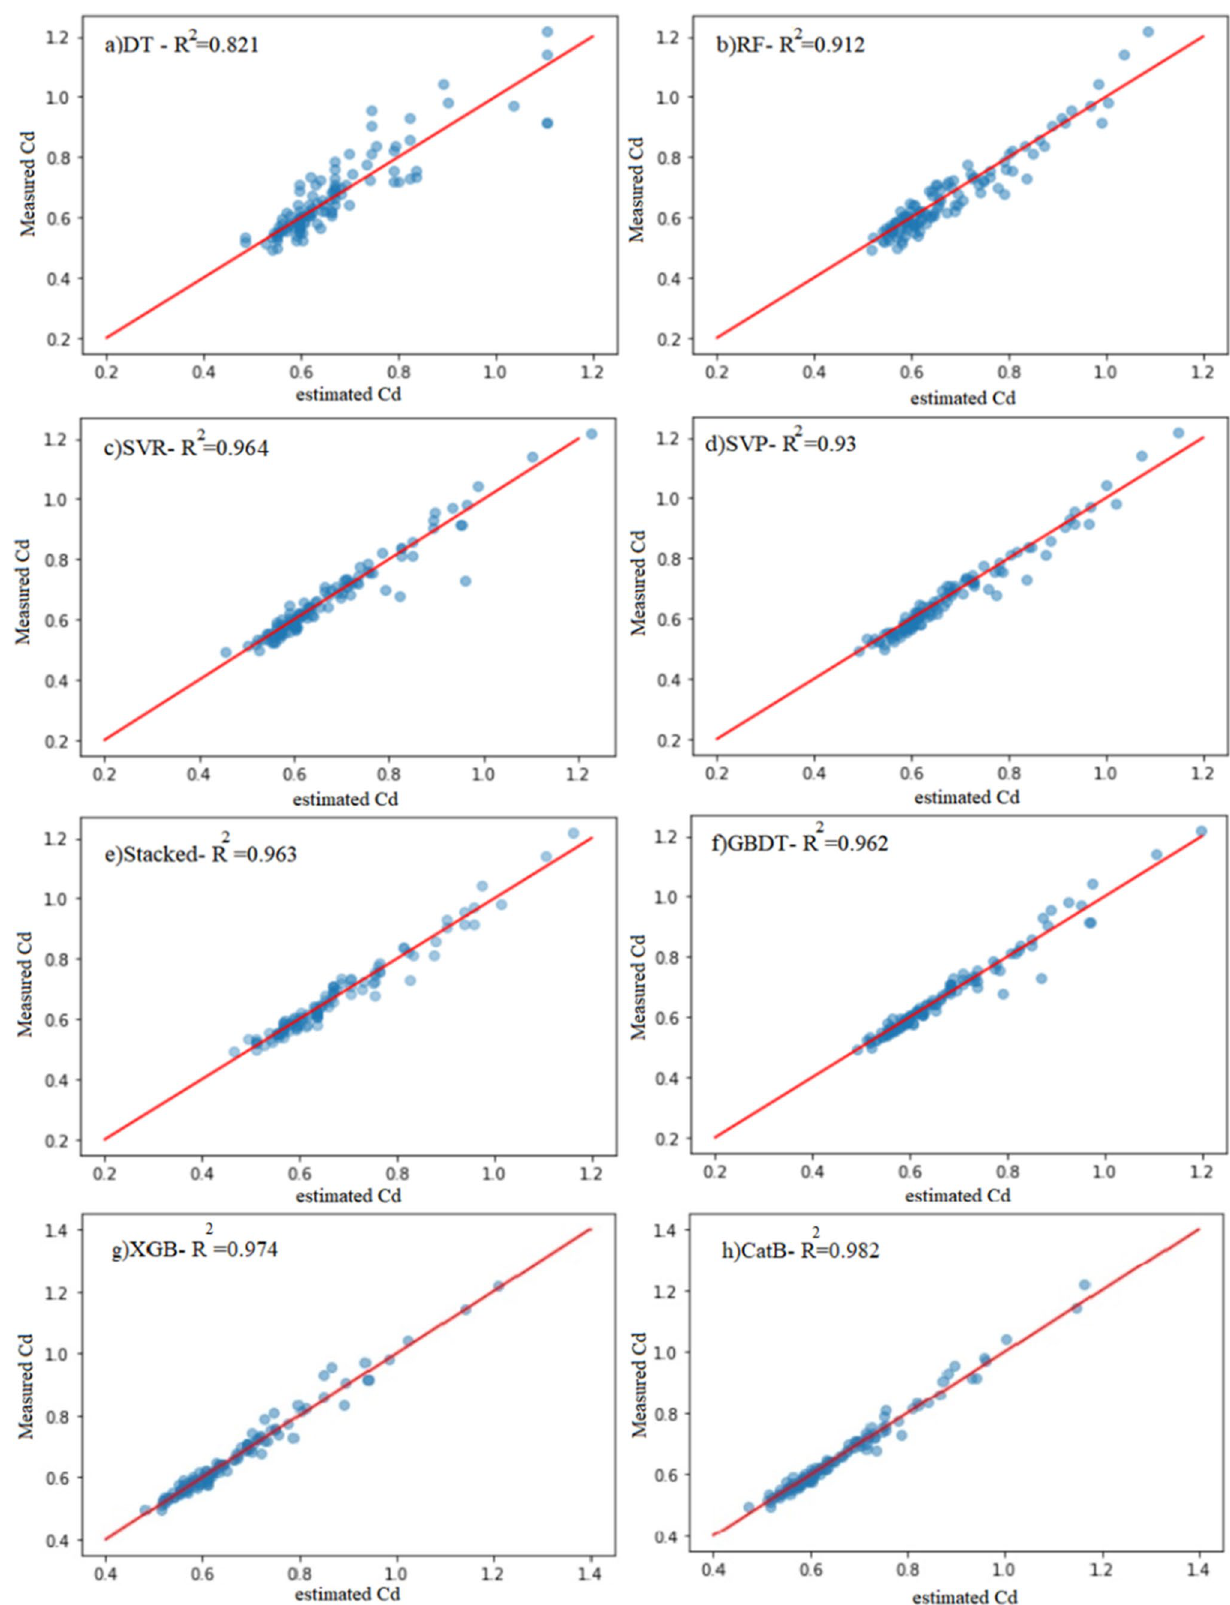
Fig. 11 Scatter plot of observed vs estimated values of C